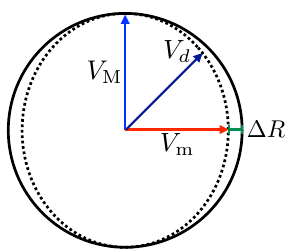
Figure 7 . Ellipticity of the cavity can lead to signal and pump mode contamination. Shown here are the major axis voltage V M and minor axis voltage V m , and a drive voltage V d , subject to a wall deformation (cid:1) R